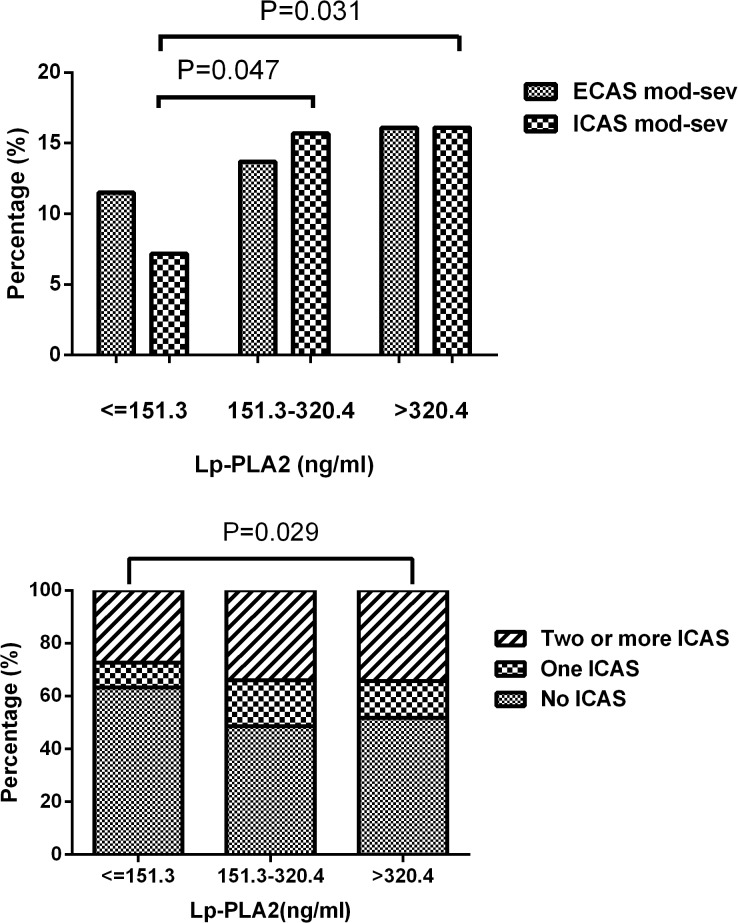
Prevalence of moderate to severe ECAS and ICAS (%) (A) and distribution of ICAS vessels (B) according to tertiles of Lp-PLA2.ECAS, extracranial arterial stenosis; ICAS, intracranial arterial stenosis; Lp-PLA2, Lipoprotein-associated phospholipase A2.